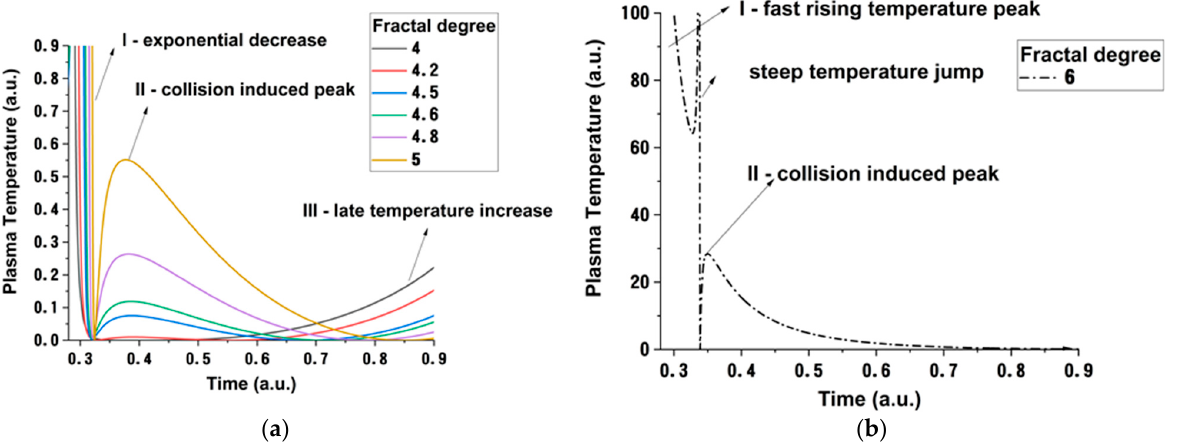
Figure 8. Temperature temporal evolution for various fractal degrees ( a ) and a particular evolution in conditions of high fractalization ( b ).